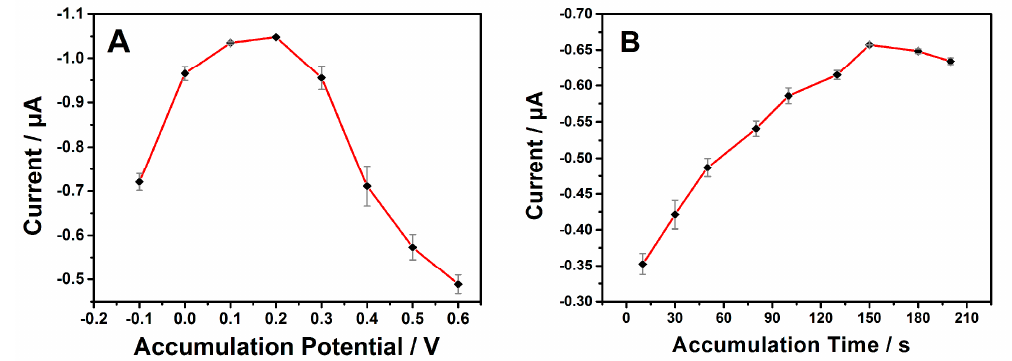
Figure 5. Relationship between peak current of LU and ( A ) accumulation potential and ( B ) accumulation time.